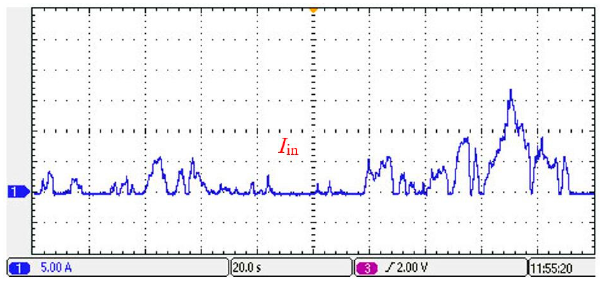
Figure 20. The converter load current waveform under the WLTP.